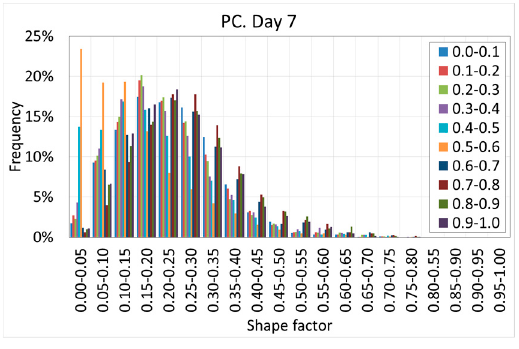
Figure 23. Histograms of the shape factors of PC at different depths and ages.